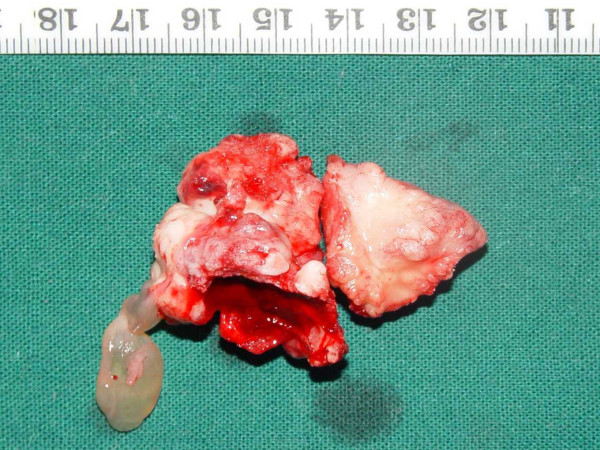
Specimen. Specimen after it was excised in 2 pieces with part of the ethmoid sinus mucous membrane attached to one of the pieces. The ethmoidal portion was subsequently drilled away.